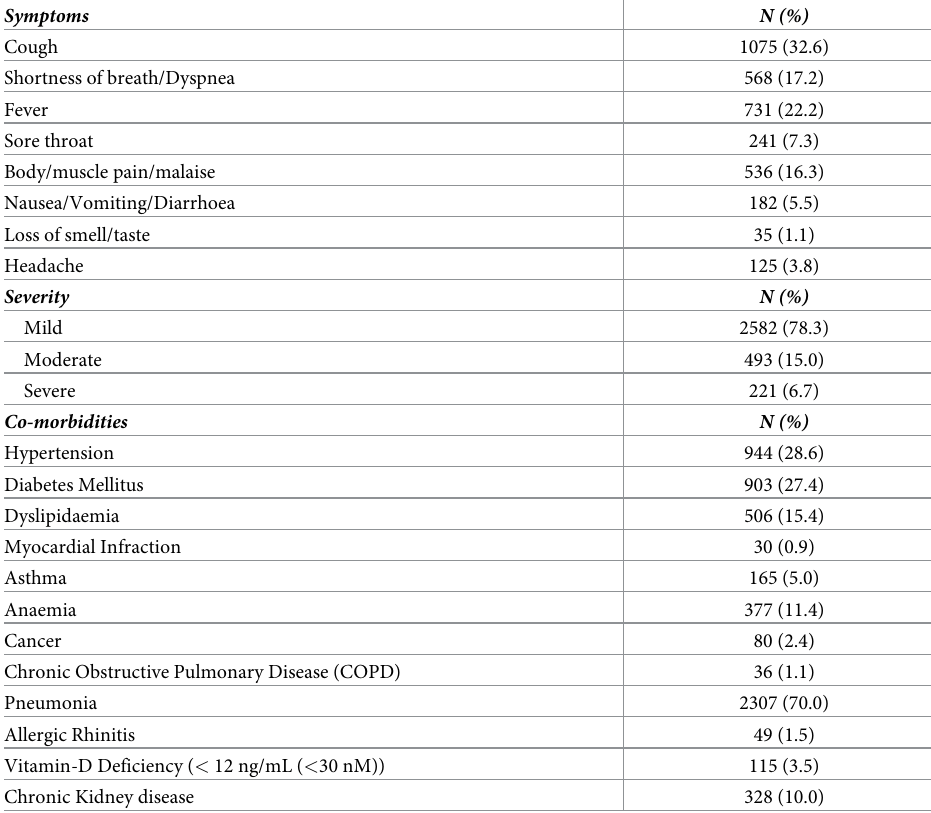
Table 2. Symptoms, severity of infection, and associated comorbidities among the patients (n =